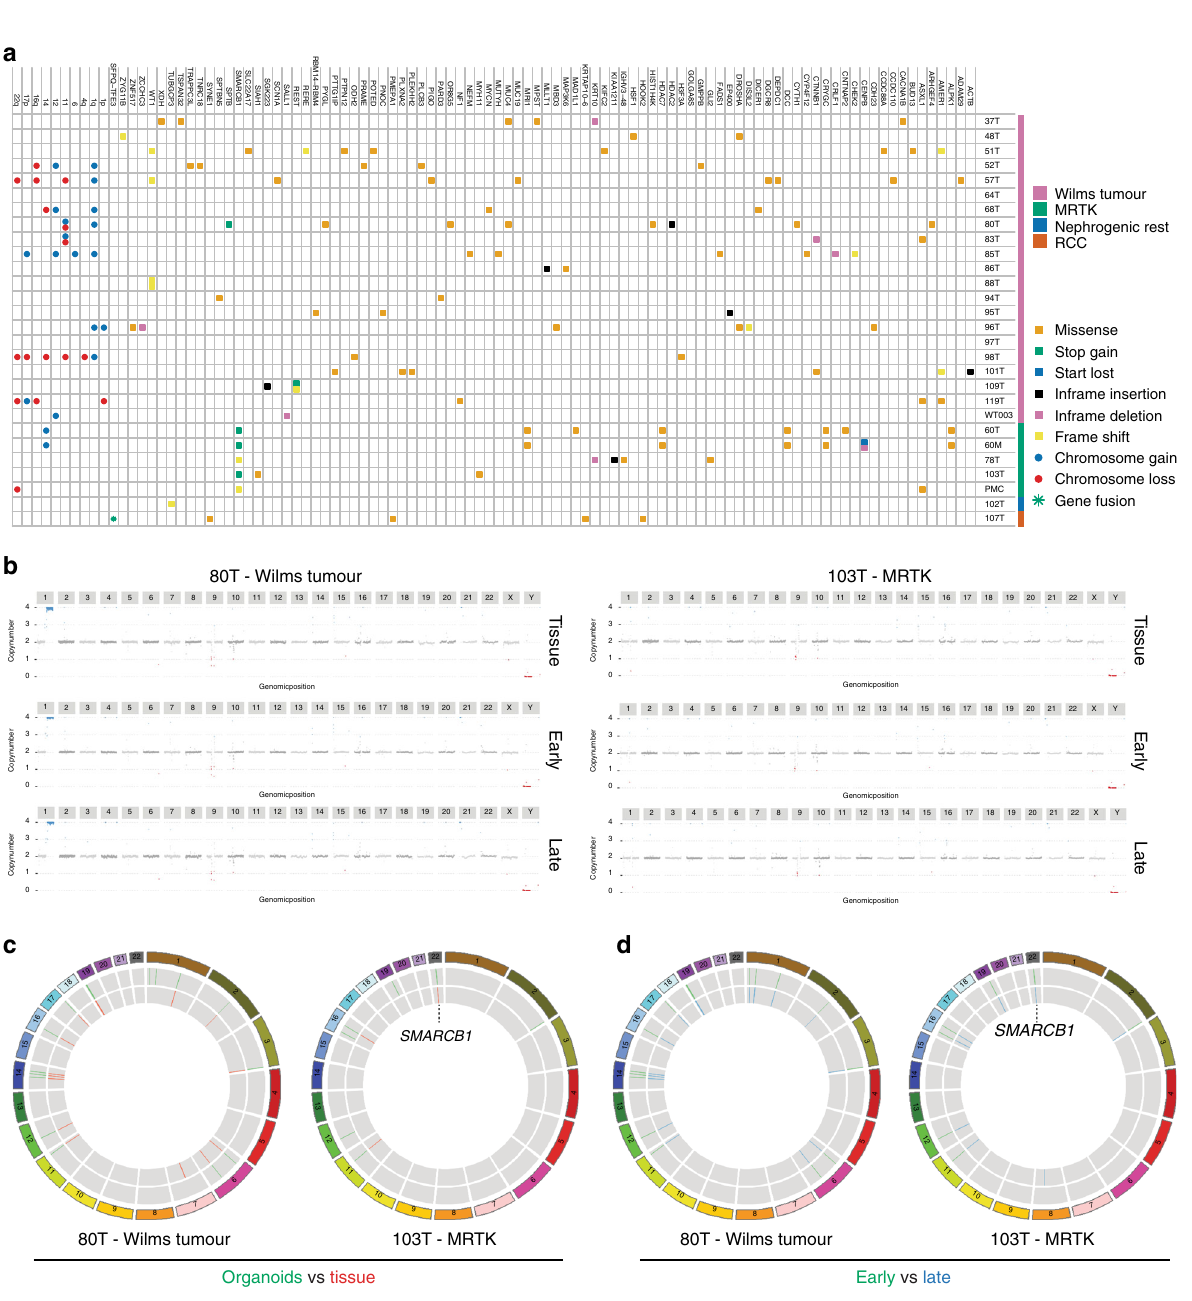
Fig. 4 Genetic characterisation of paediatric kidney cancer organoids reveals common driver mutations and copy number alterations. a Overview of somatic mutations identi fi ed in paediatric kidney cancer organoids compared with their matching normal kidney organoids. When matching normal kidney organoids were not available, somatic mutations in known driver genes are indicated. Variant allele frequencies are given in Supplementary Data 2. b Genome-wide CNAs (karyograms) and coding gene mutations (circos plots) ( c , d ) in matching tumour tissue vs organoid and early vs serially passaged (P4, P5 vs P10, P11) re fl ecting ~3 months of culturing) organoid pairs reveal that organoids recapitulate the genetic landscape of the tissue they were derived from and that this genetic landscape is retained over